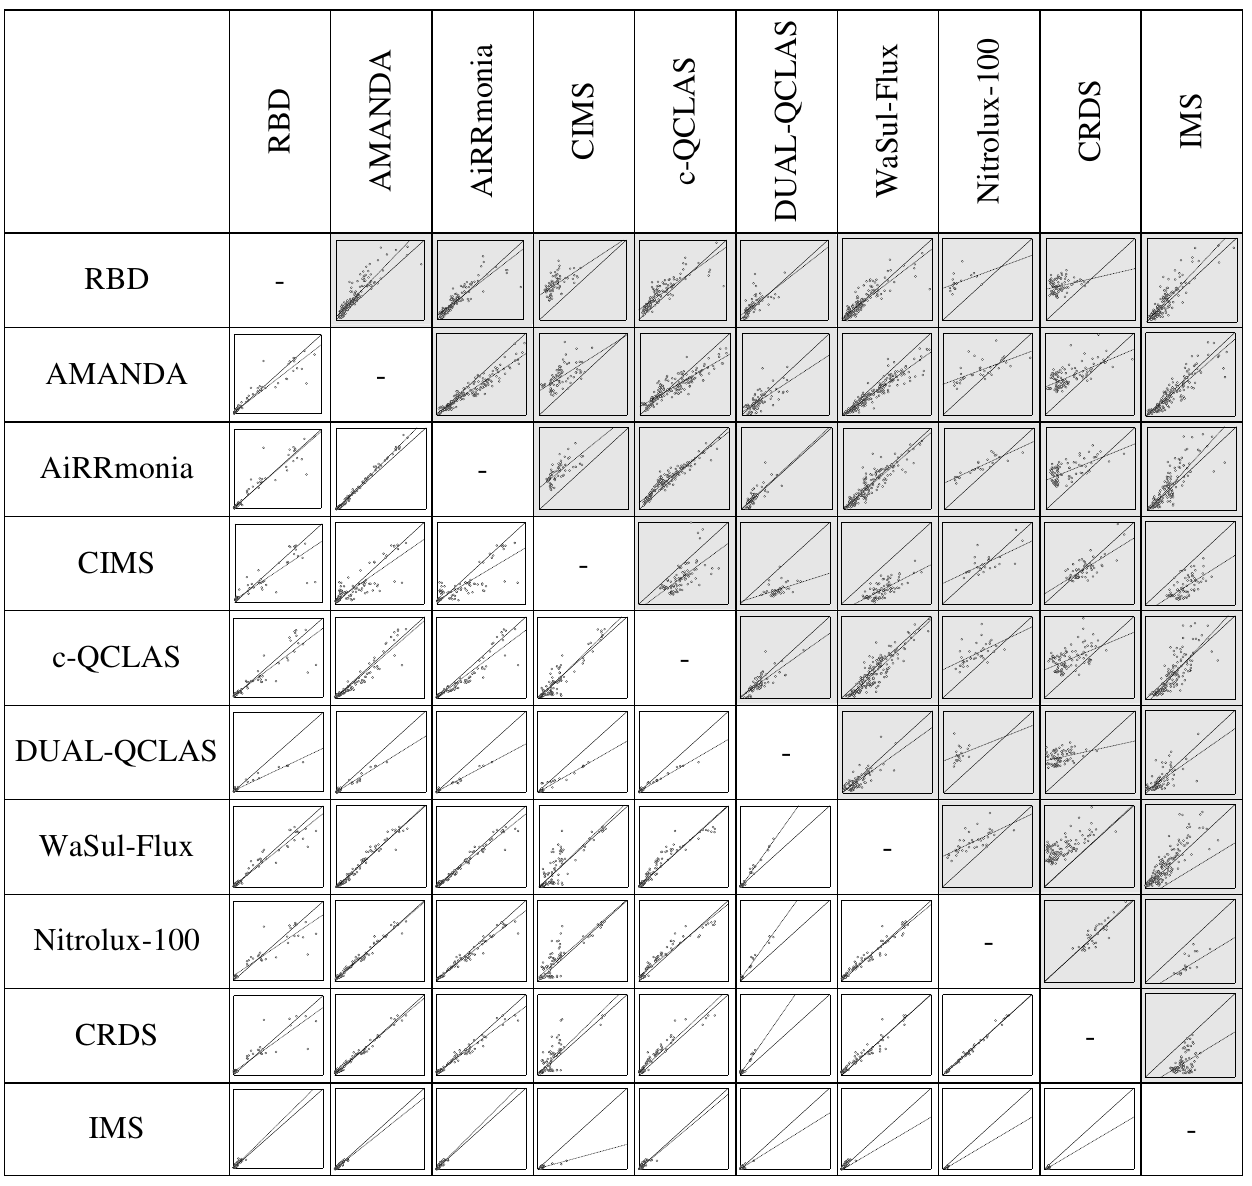
Table 8. Linear regression between each instrument for the entire data range (bottom left) and less than 10 ppbv (shaded top right).